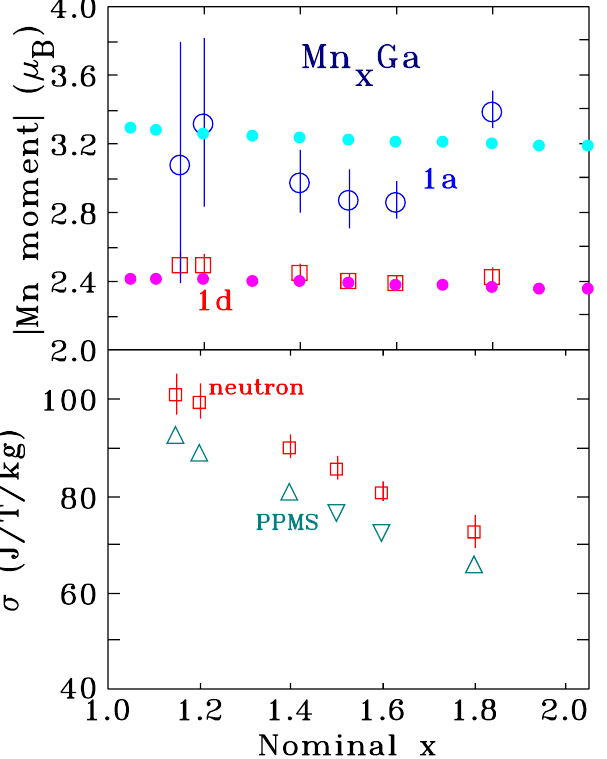
Figure 6. (top) The open symbols show the fitted Mn moments for the two sites in the P4/ mmm Mn x Ga structure. The moment of the manganese on the 1 d site is essentially constant at 2.45(3) μ B /Mn while a slightly larger antiparallel moment of ~3 μ B /Mn appears on Mn atoms that occupy the 1 a site. Also shown as solid points are the corresponding moments calculated using DFT. (bottom) Net magnetisation derived from the neutron scattering fits (neutron) compared with values obtained from bulk magnetisation data